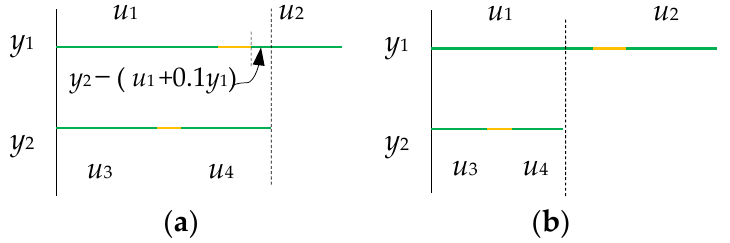
Figure 4. The ratio between the cycle and green light durations when y 1 > y 2 ( a ) u 1 < y 2 and ( b ) u 1 > y 2 .